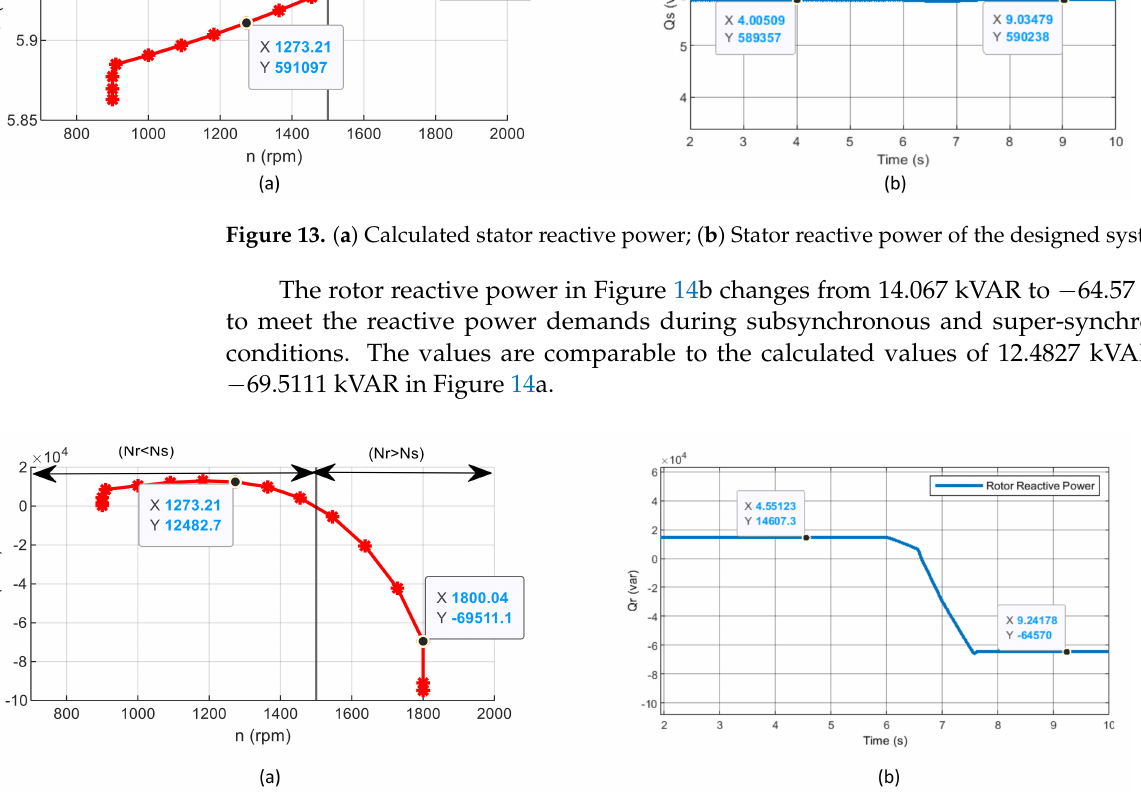
Figure 14. ( a ) Calculated rotor reactive power; ( b ) Rotor reactive power of the designed system. The values of I s , I r , V s , V r , P s , P r , Q s, and Q r obtained through computation and